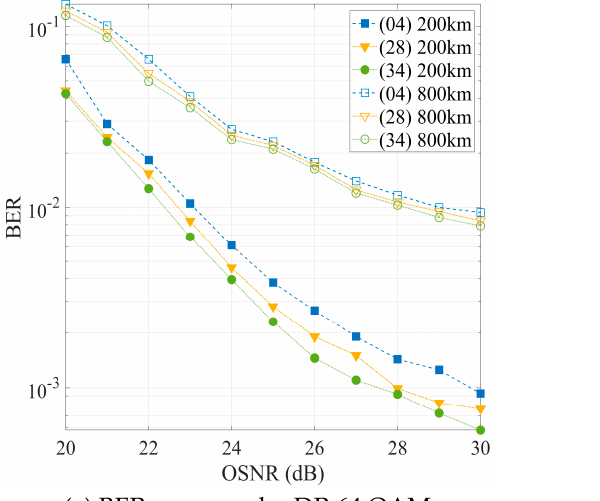
Figure 4. The BER performance of DP-QPSK and DP-16 QAM data with Ω ∈ [ − 3 π /8,3 π /8 ] , the Figure 4. The BER performance of DP - QPSK and DP-16 QAM data with [ 3 / 8,3 / 8] π π Ω ∈ − , the filter (4) has 211 taps, while filter (28) and (34) have 131 taps. filter (4) has 211 taps, while filter (28) and (34) have 131 taps.